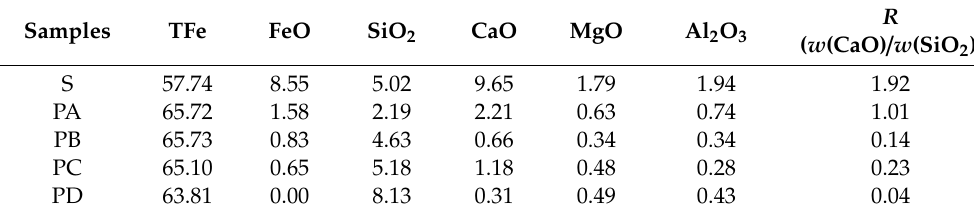
Table 1. Chemical compositions of the raw materials (wt%).